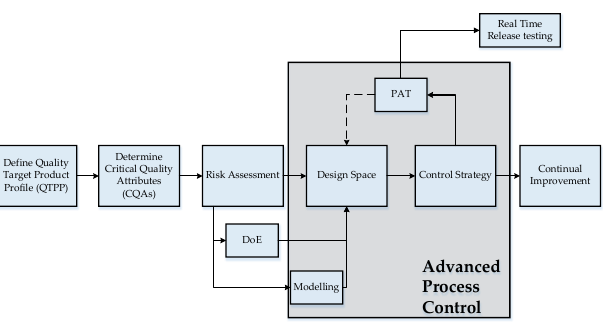
Figure 1. QbD process development workflow [6]. Table 1. Critical quality attributes and process parameters in lyophilization [1,7].